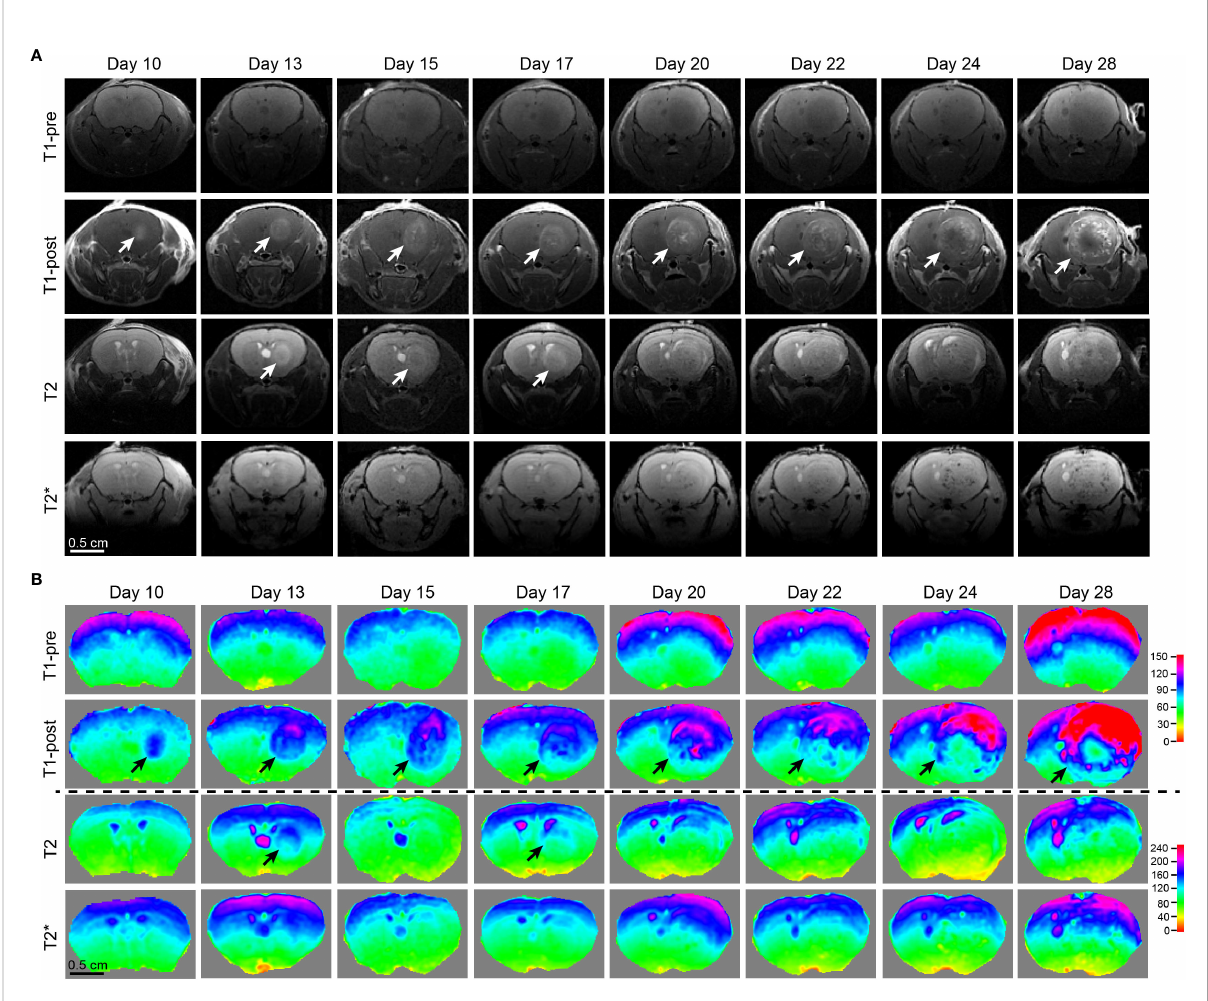
FIGURE 3 Comparison of different MRI modalities for temporal visualization of tumors and tumor necrosis using a murine GBM model. (A) Images acquired from various frequently utilized MR imaging modality for diagnostics and pre-operative planning in the clinical setting on the GBM tumor-bearing mouse devised by our lab. Starting from 10 days post tumor cell implantation, the mouse underwent serial brain MRI. Time points were pre-determined based on our previous histological studies on days 10, 13, 15, 17, 20, 22, 24, and 28, which is the end point of this GBM tumor-bearing mouse. (B) Heatmaps of signal intensities generated using MRI images as in panel (A) . Arrows: Enhancing areas likely representing tumors. One mouse was